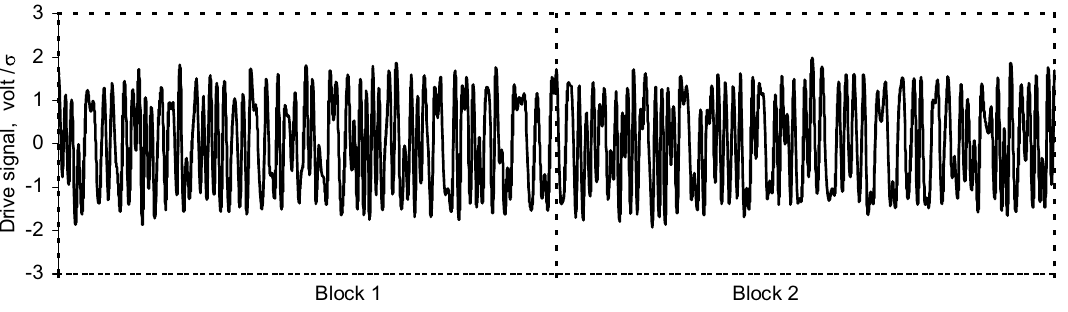
Fig. 1. Each new data block is different in the drive signal with low